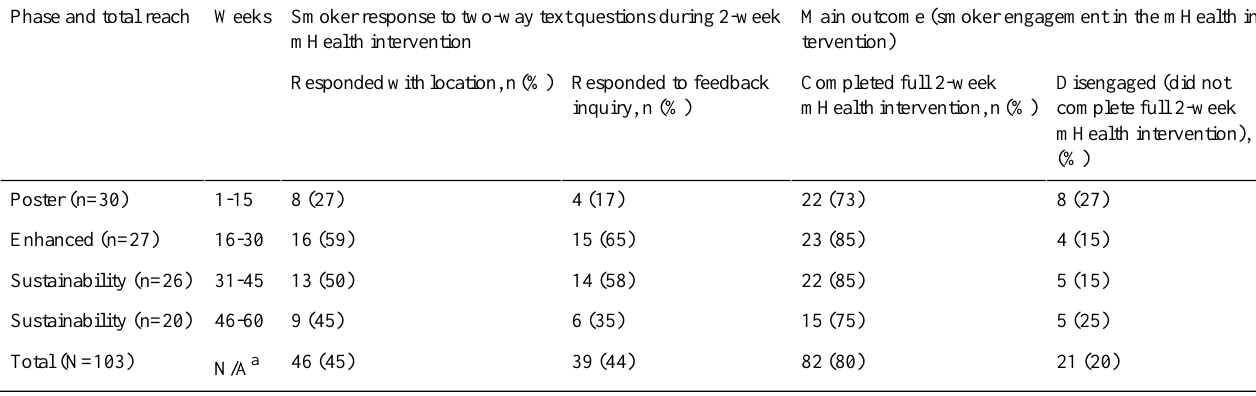
Table 2. Technology Inpatient Program for Smokers mHealth intervention engagement (main outcome) by